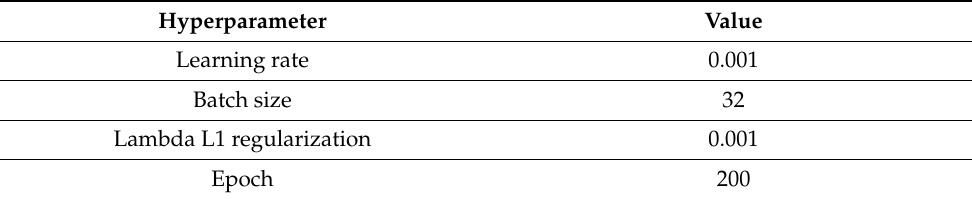
Table 7. DAE hyperparameters.